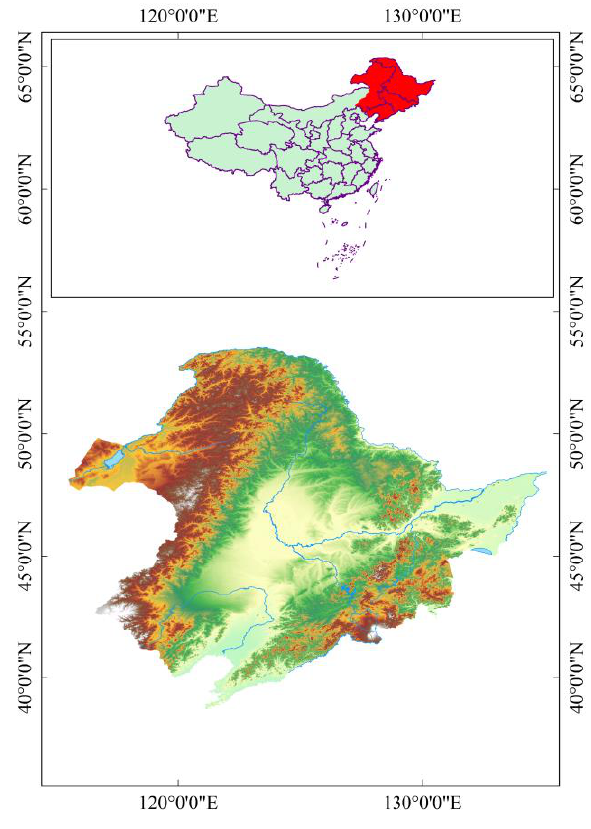
Figure 1. The Study